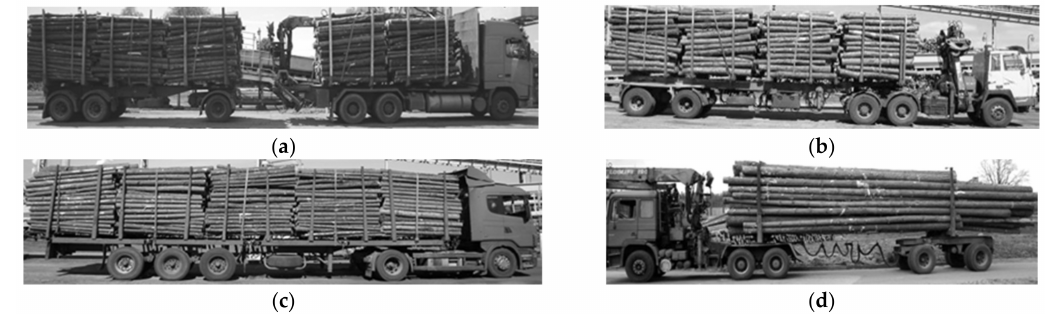
Figure 2. Examples of truck units: ( a ) truck and trailer, ( b ) truck and semi-trailer, ( c ) truck and lightweight platform semi-trailer and ( d ) truck and